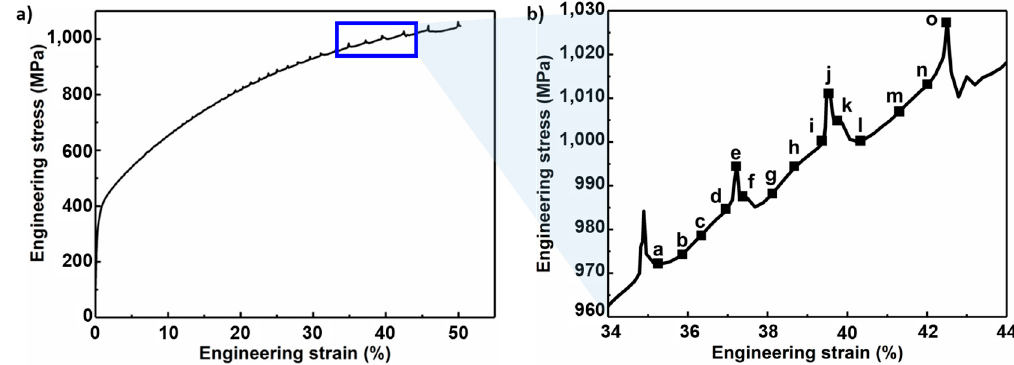
Figure 1. Engineering stress–strain curves of the annealed Fe-18Mn-0.6C steel ( a ) and the serrated flow with strains of 34–44% ( b